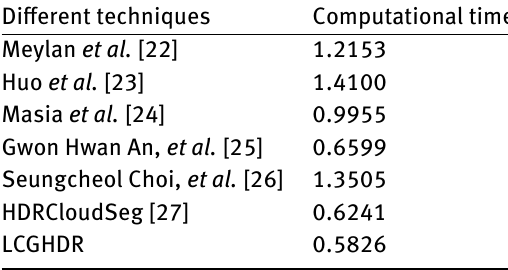
Table 7: Computational time analysis of various HDR method